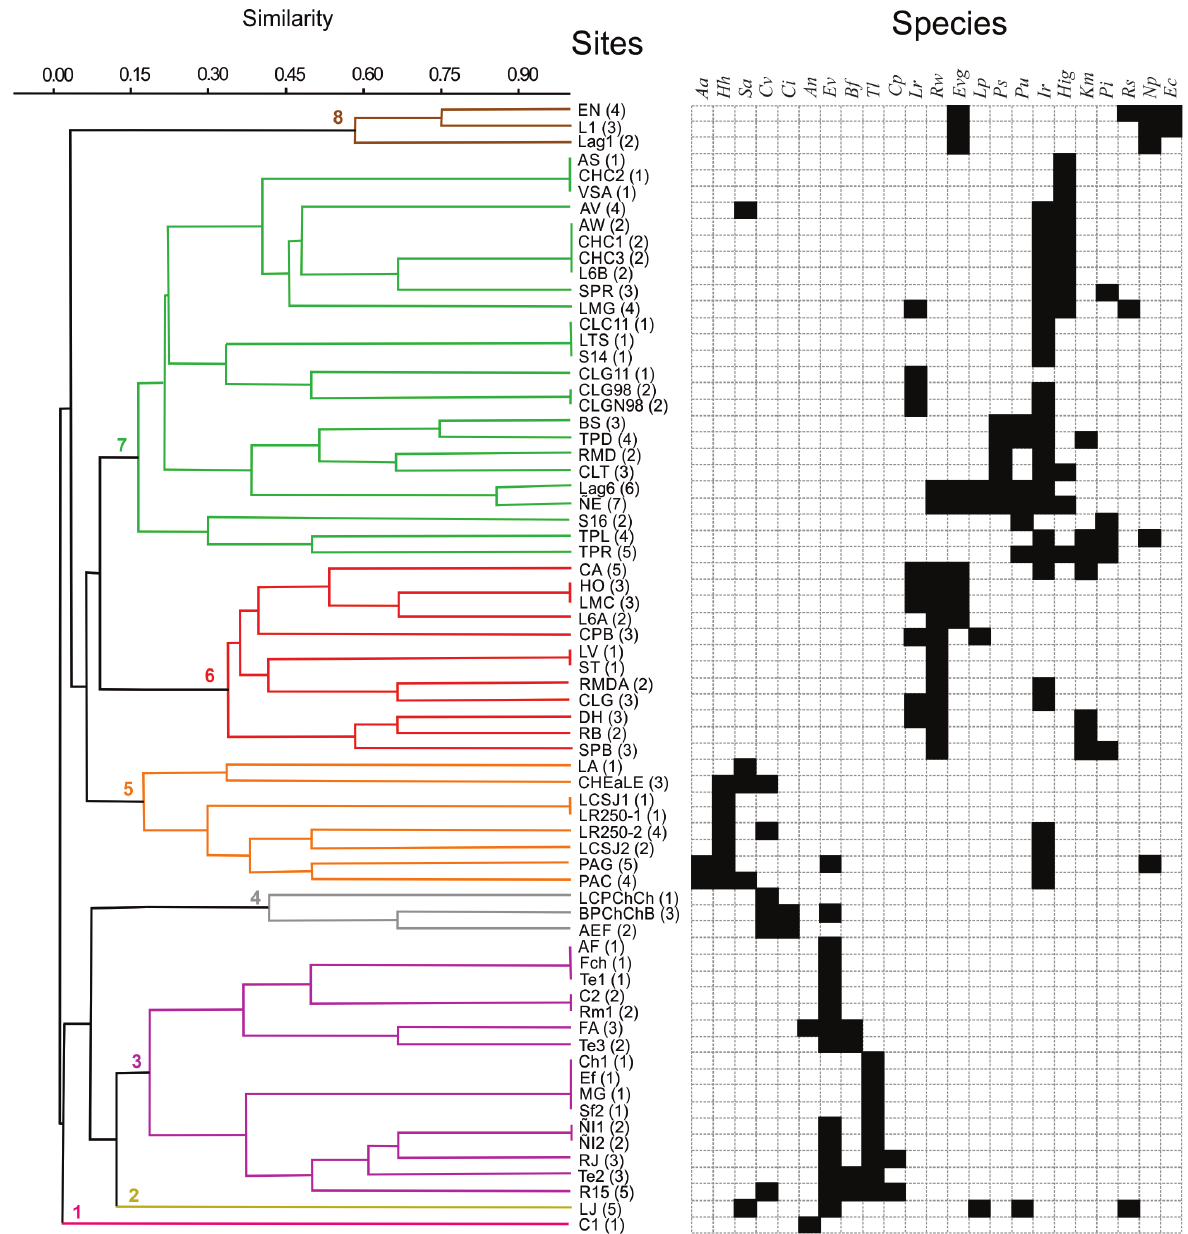
Figure 2. Dendrogram of sites and their species. Dendrogram showing eight clusters (1 – 8) separated by 0.15 units of similarity, obtained using the Unweighted Pair Group Method (UPGMA) and Jaccard Similarity Index. Coffenetic Correlation Coefficient (CCC) = 0.8307. Abbreviation of species names are shown in Table II. Numbers between parentheses indicate number of species at each